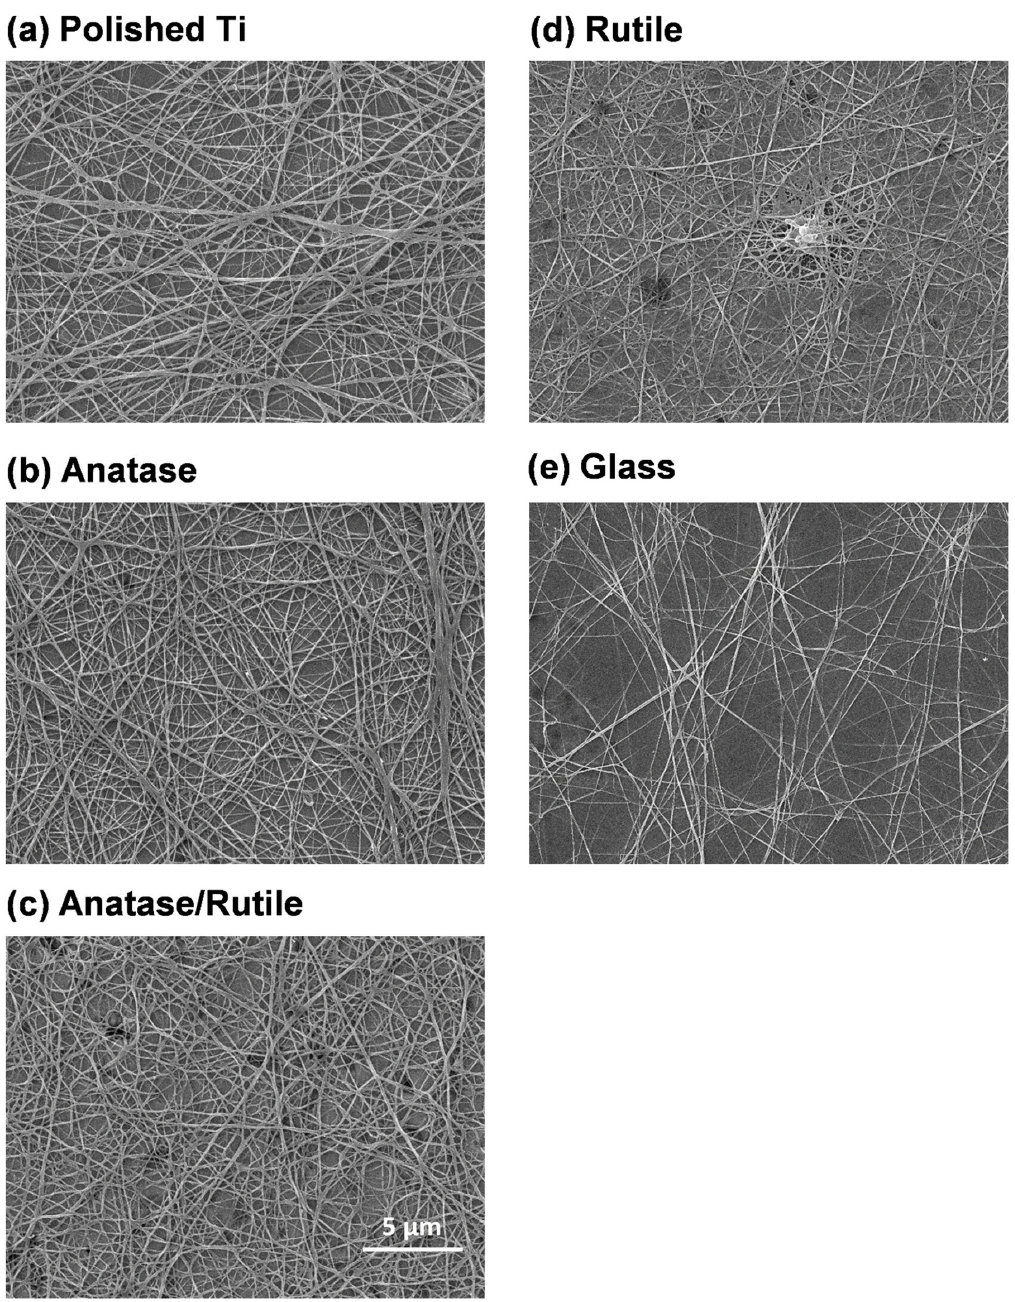
Figure 6. Attachment of fibrin on test specimens’ surfaces, observed using SEM. Rutile phase surface was almost completely fused with the reticulated fibrin.